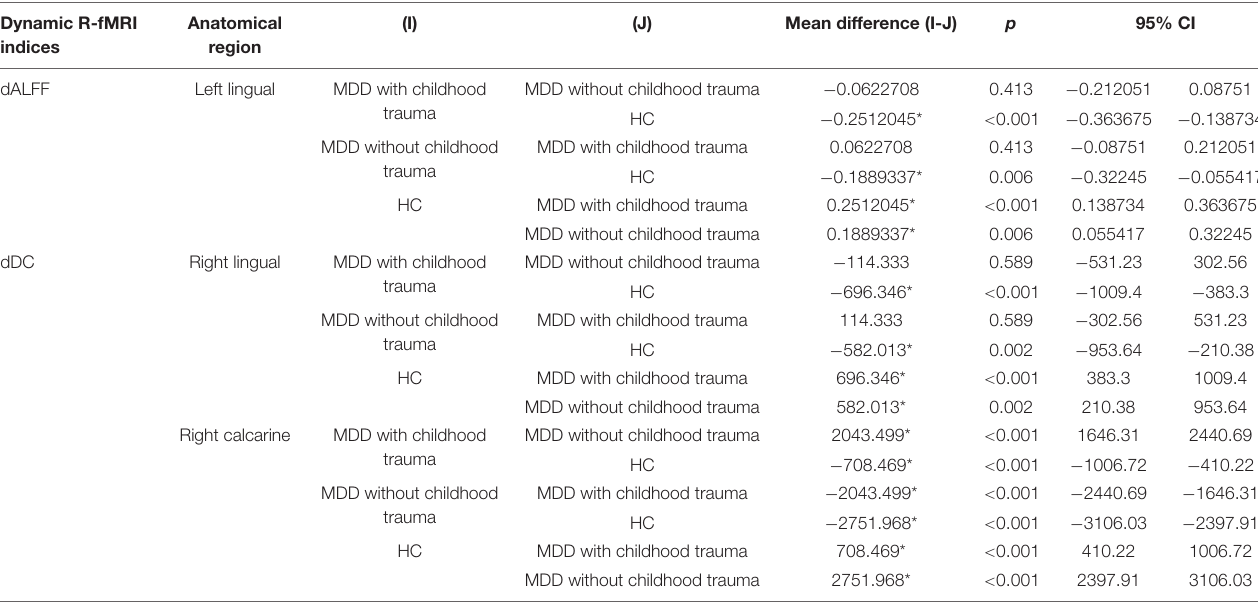
TABLE 3 | Multiple comparisons in regions with differences in dALFF and dDC.